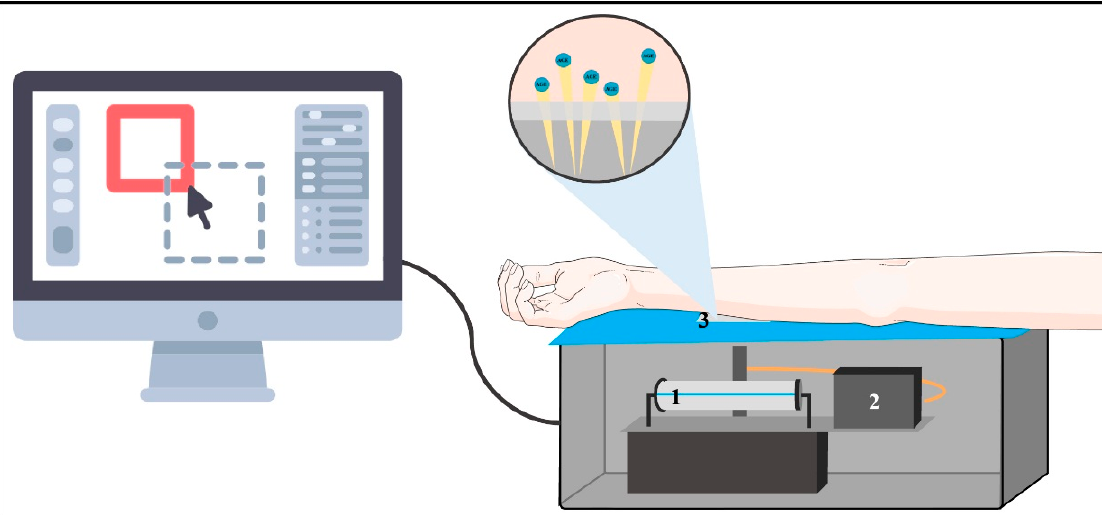
Figure 5. From the surface: the interior of the Skin Autofluorescence Reader. The Skin Autofluorescence Reader consists of a tube that illuminates UV radiation with an intensity of 300–420 nm upon approximately 1 cm 2 of skin, which must not have scars or other abnormalities. The test must be performed in a semi-dark environment to avoid light interference. Said stimulus excites AGEs, which are bound to skin proteins and have autofluorescent properties within that range. These emit their fluorescence from light waves within a range of 420–600 nm and can be detected by a spectrometer. The autofluorescence of the stimulated AGEs is measured by the proportion between the intensity of the emitted light (420–600 nm) and the excitation light (300–420 nm) multiplied by 100, aiming to compensate for the effect of the skin pigmentation in the capacity of light absorption on the autofluorescence. The obtained results are expressed in arbitrary units (AU) and are shown immediately in a computed connected to the measurer, with a reference established from the results considering the patient’s age. (1) Source of UV light, (2) spectrometer, and (3) illumination